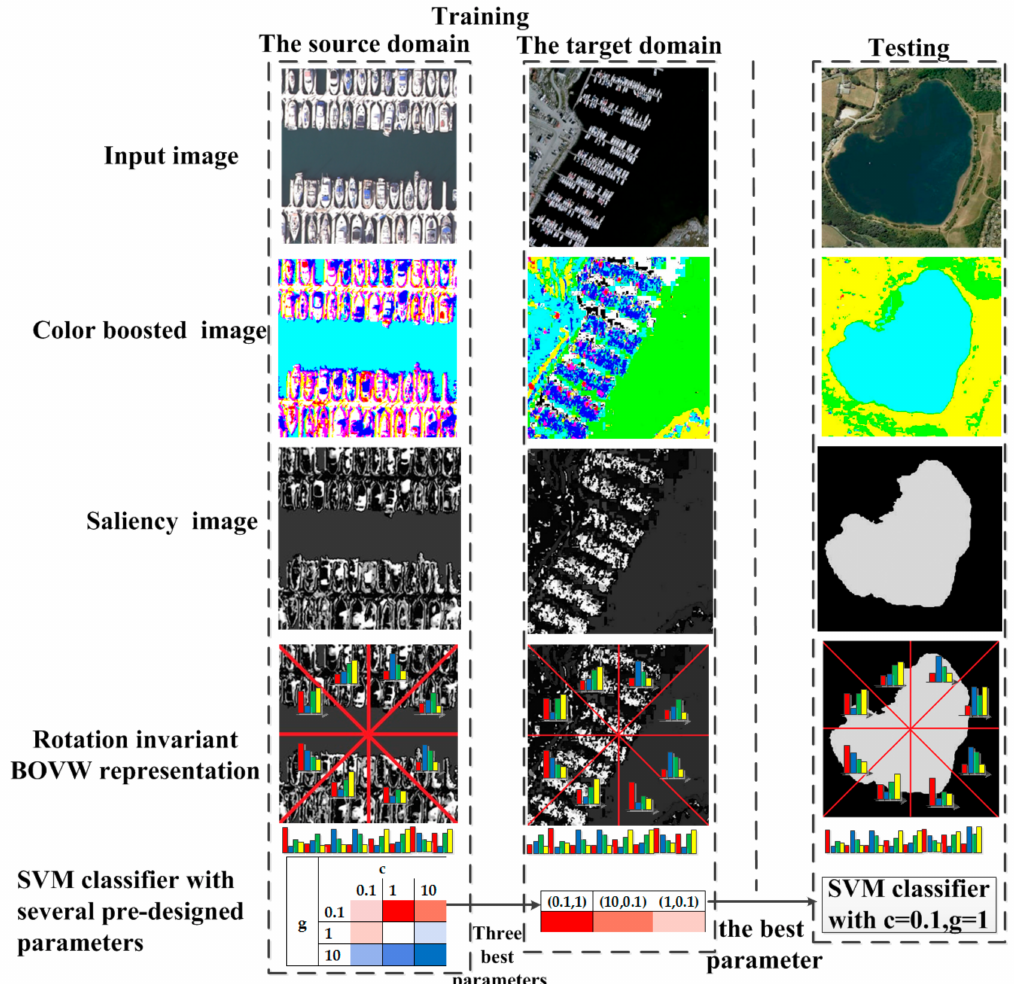
Figure 2. The architecture of the proposed color boosted saliency-guided rotation invariant BOVW approach with parameter transfer. The color indicates the performance of the classifier from dark red to dark blue where the parameter with dark red performs the best and that with dark blue delivers the poorest